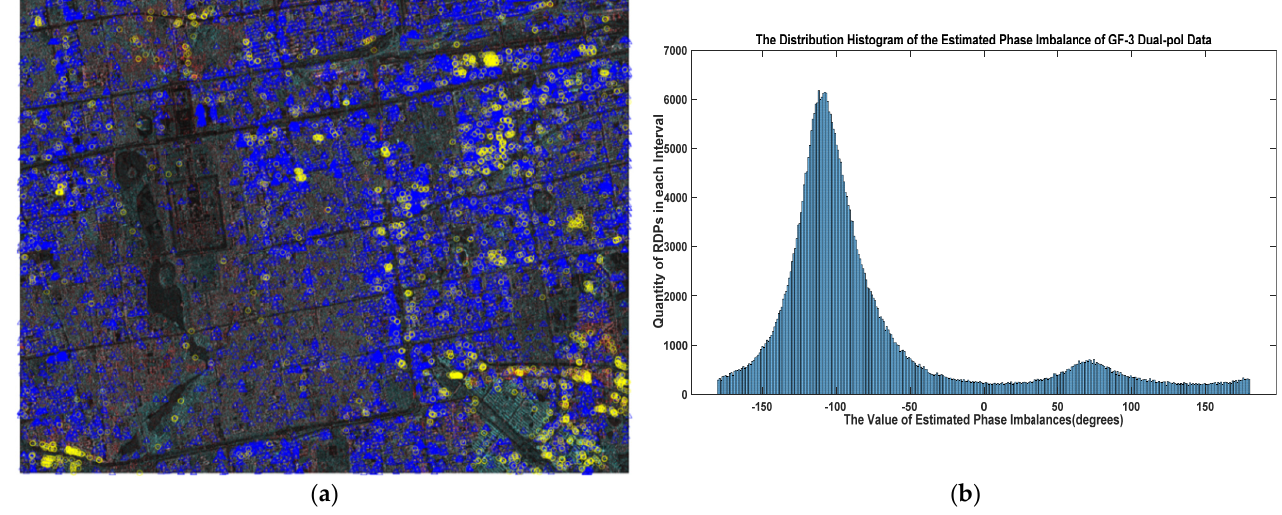
Figure 7. The phase imbalance estimation results of GF-3 uncalibrated dual-pol SAR data: ( a ) The extracted RDBs are displayed locally in the Beijing urban area (Product ID: 2931251). The color assignment is red for the HH channel, green for the HV channel, and blue for the HV channel divided by the HH channel; ( b ) the distribution histogram of the estimated phase imbalances of the extracted RDBs of the whole scene.